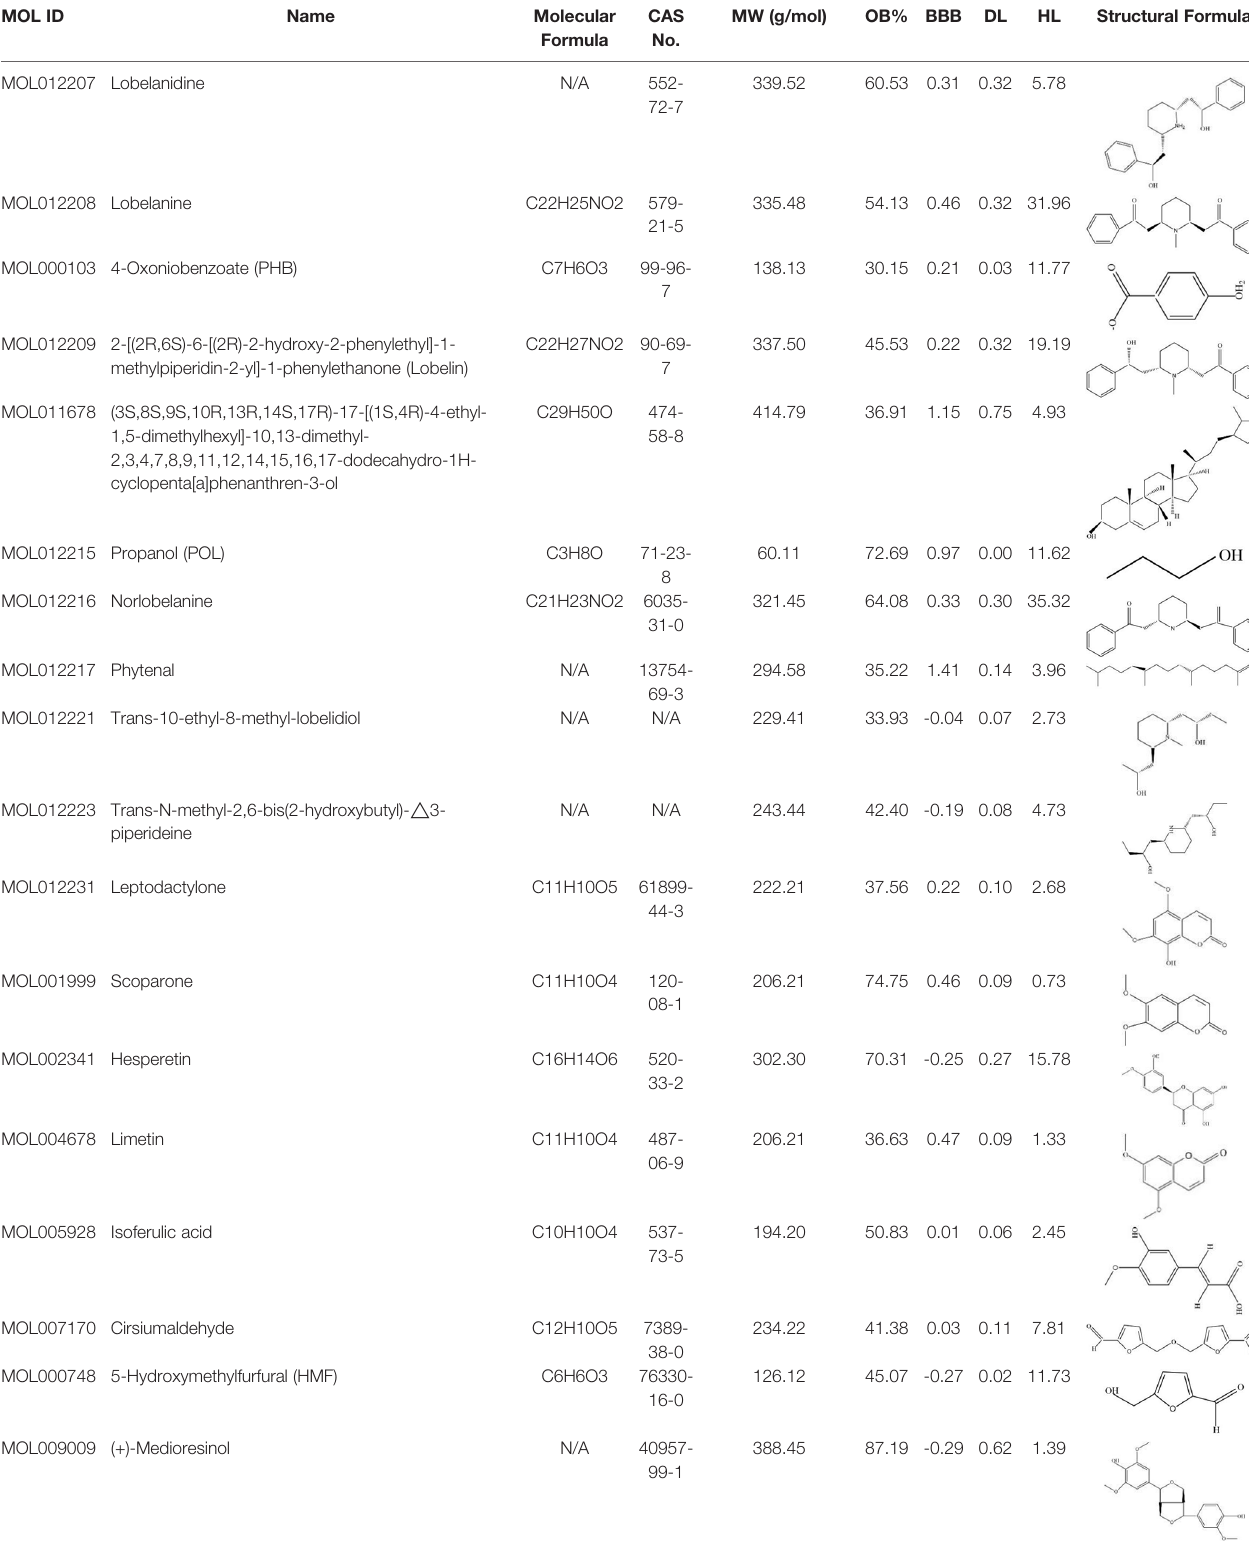
TABLE 2 | Ingredients information of Lobelia chinensis